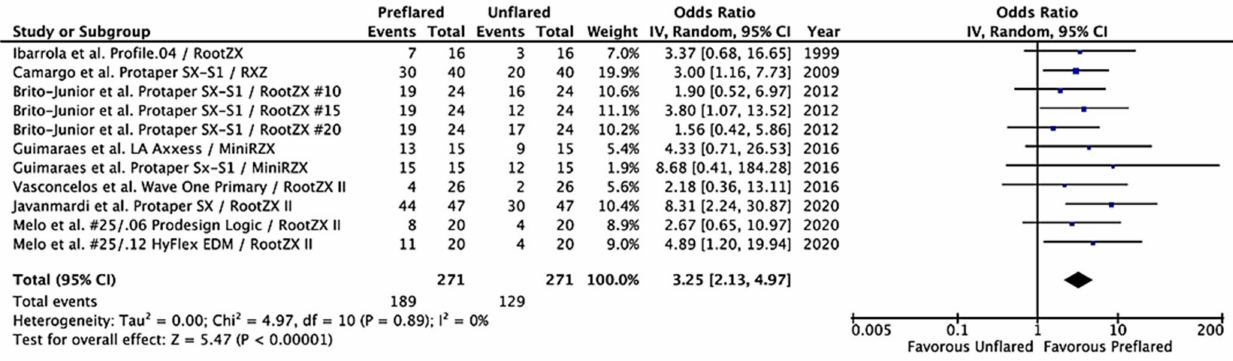
Figure 4. Forest plot of ORs and 95% confidence limits (CL) for the comparison of unflared and preflared canals regarding the accuracy of Root ZX in working length (WL) determination. The overall estimate is based on the data from the seven included studies. Black squares represent the point estimate of the odds ratio and have areas proportional to study size. Lines represent 95% confidence intervals. The diamond shows the summary statistic for the 11 results from the seven included studies. The solid line indicates an odds ratio of 1.0. OR: odds